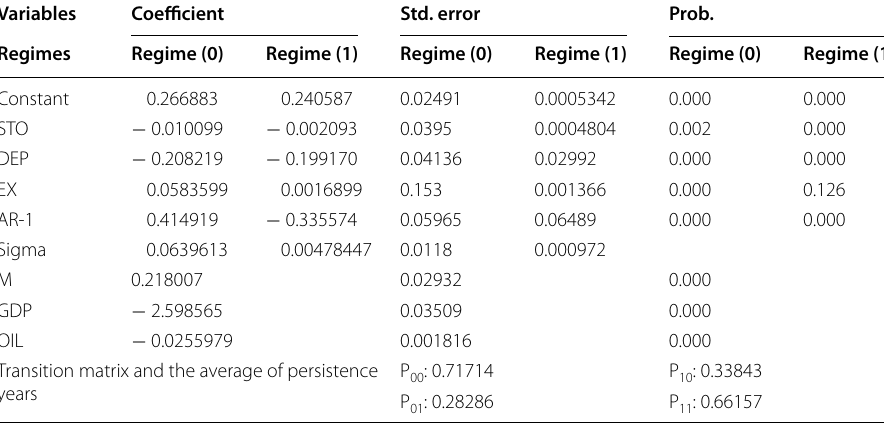
Table 4 The estimation results of equation CPI